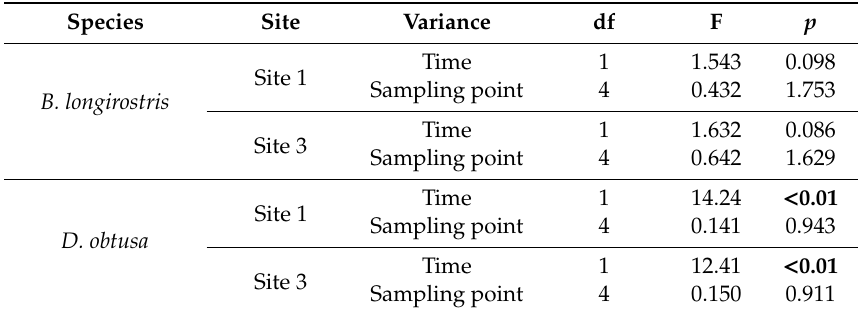
Table 2. One-way nested ANOVA results for the effects of the main groups (shown as “Time” in the table: daytime and night) and subgroups (i.e., shown as “Sampling point”) on two cladoceran species. df, Degrees of Freedom. Statistically significant values are indicated in bold.